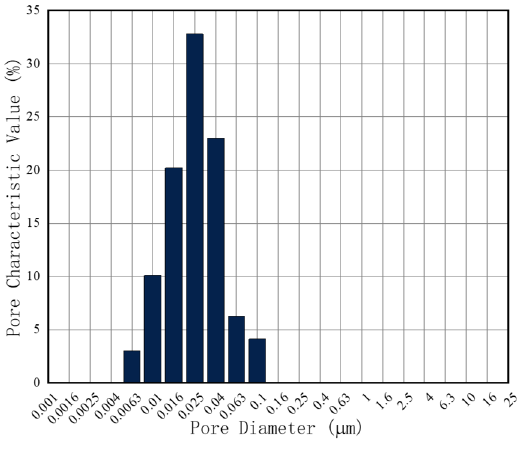
Figure 9. Reconstructed digital core of shale with an average pore–throat diameter of 130 nm.